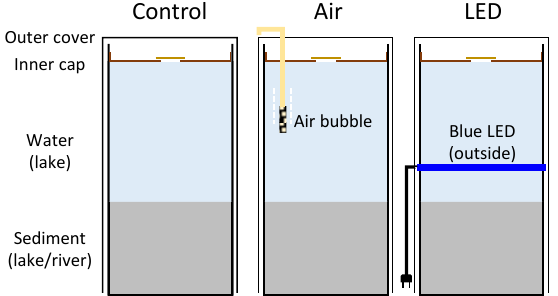
Figure 2. Schema of the three types of microcosms.